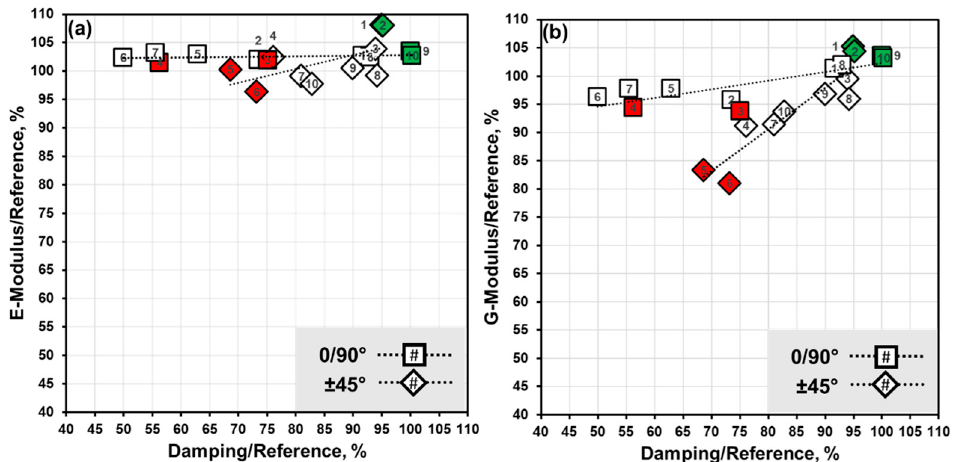
Figure 8. Correlation of E- ( a ) and G-moduli ( b ) and average ACU damping of bending bars (relative to reference samples). No significant correlation is found for E-moduli irrespective of sample orientation ( a ) whereas G-moduli are correlated to ACU damping only for ± 45 ◦ samples ( b ).